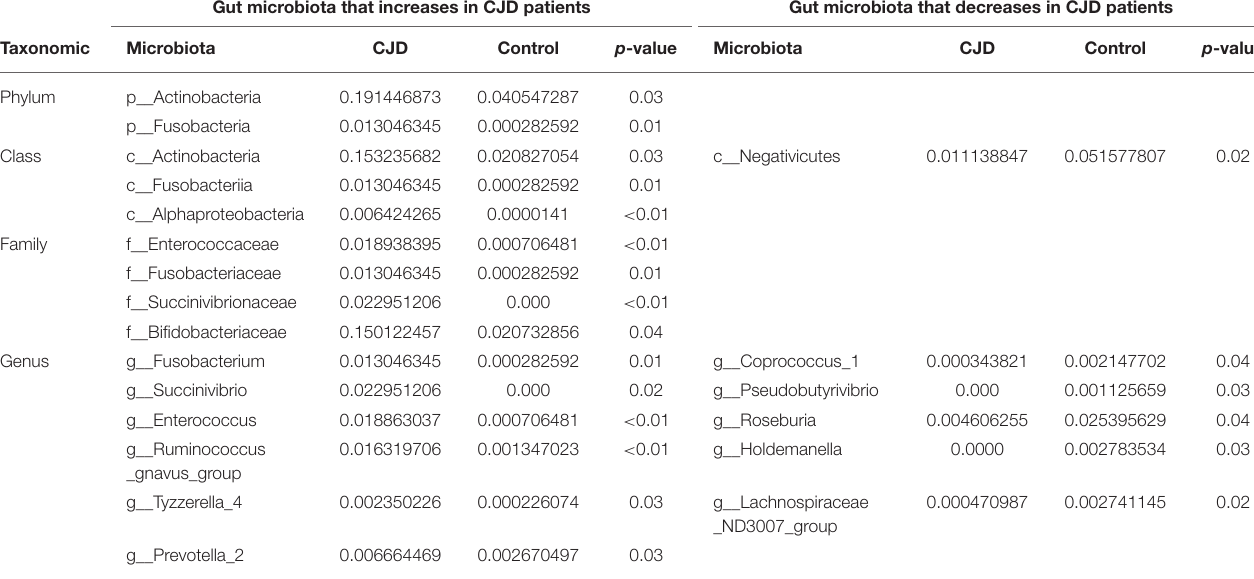
TABLE 2 | Gut microbiota with significant alteration in CJD